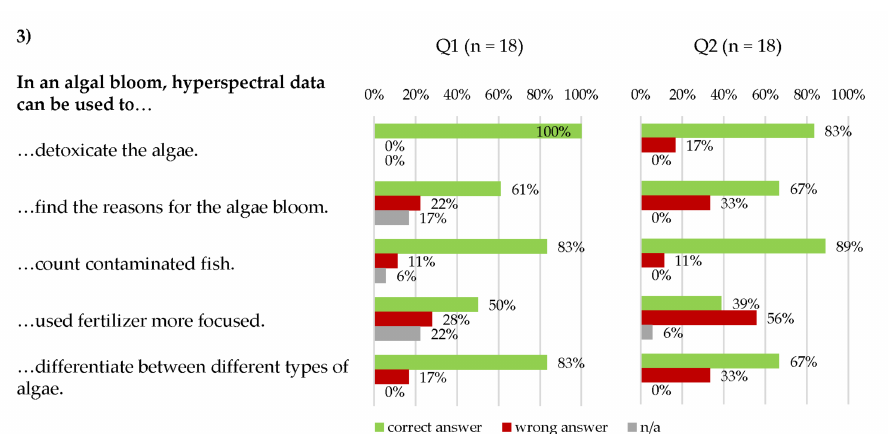
Figure 19. Answers from both test groups about the use of hyperspectral data in algal blooms.